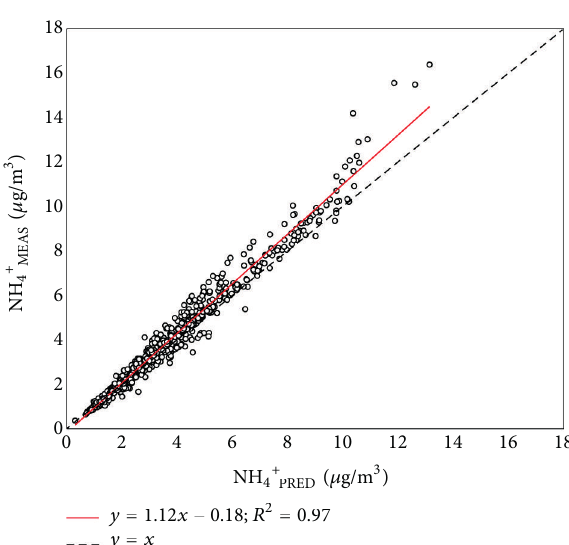
) and measured amount of ammonium (= PRED